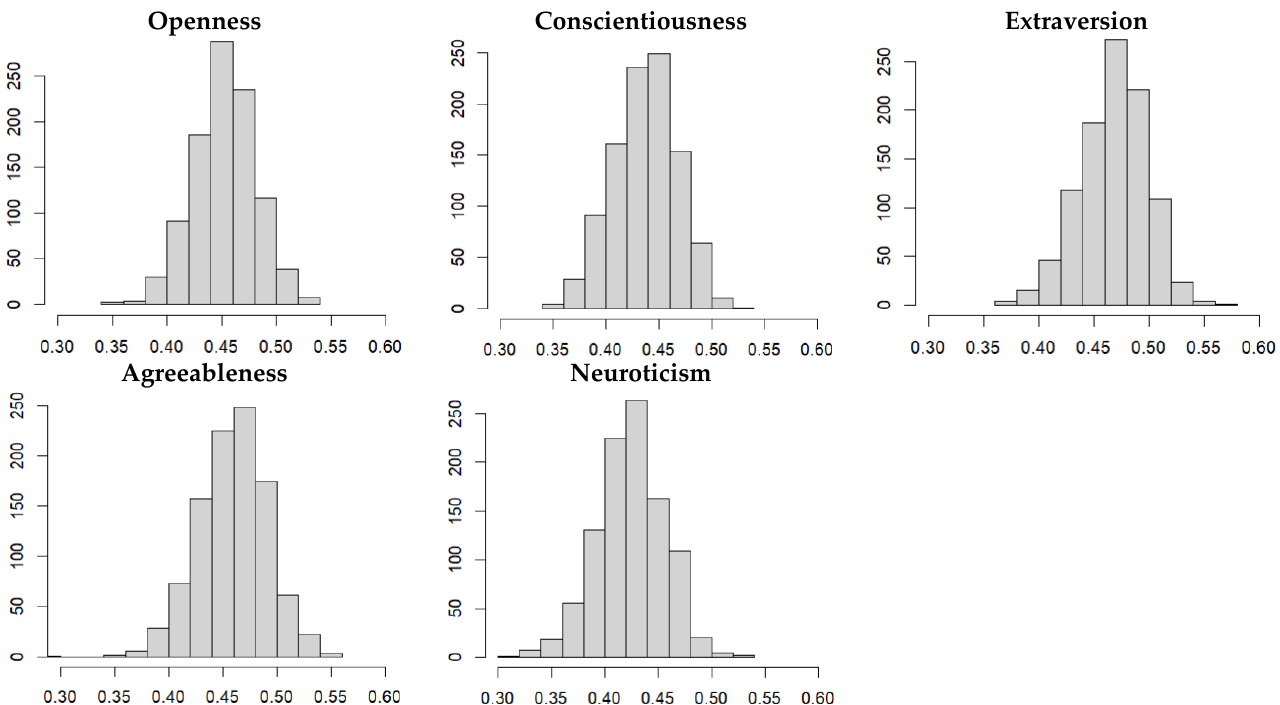
Figure 1. Distribution of model performances ( R measures) in the training data sets. x-axis ranges from 0.30 to 0.60.